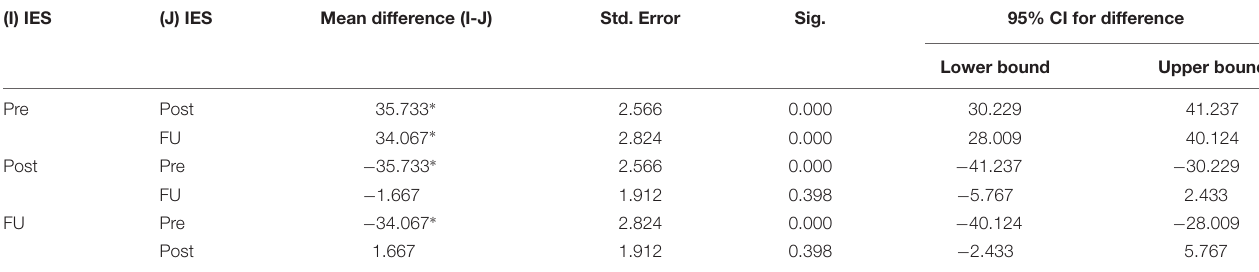
TABLE 6 | Pairwise comparisons for the weekly treatment